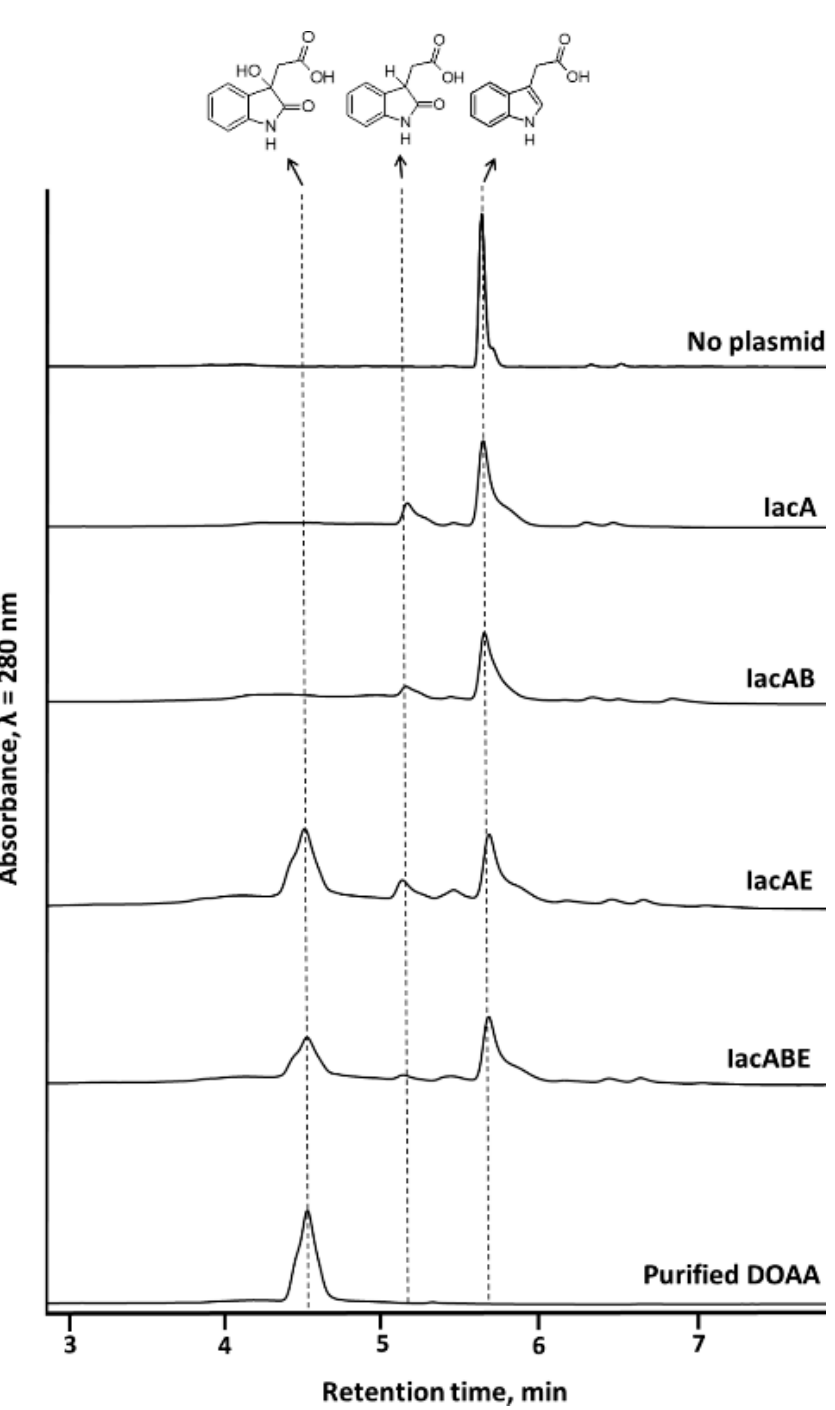
Figure 4 . HPLC analysis of the bioconversion reaction mixture of IAA (1 mM) with E. coli whole-cells expressing different combination of IacA, IacB and IacE proteins. Formulas of the identified compounds are presented. Bioconversion reactions were carried out at 30 °C overnight.